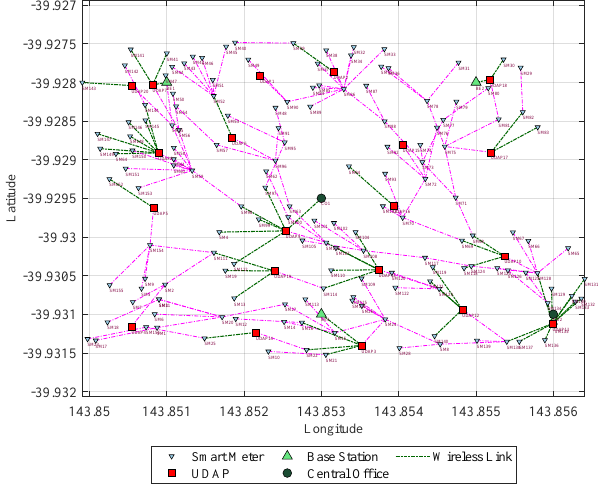
Figure 5. Topology with capacity of 20 users per node and range of 75 m.